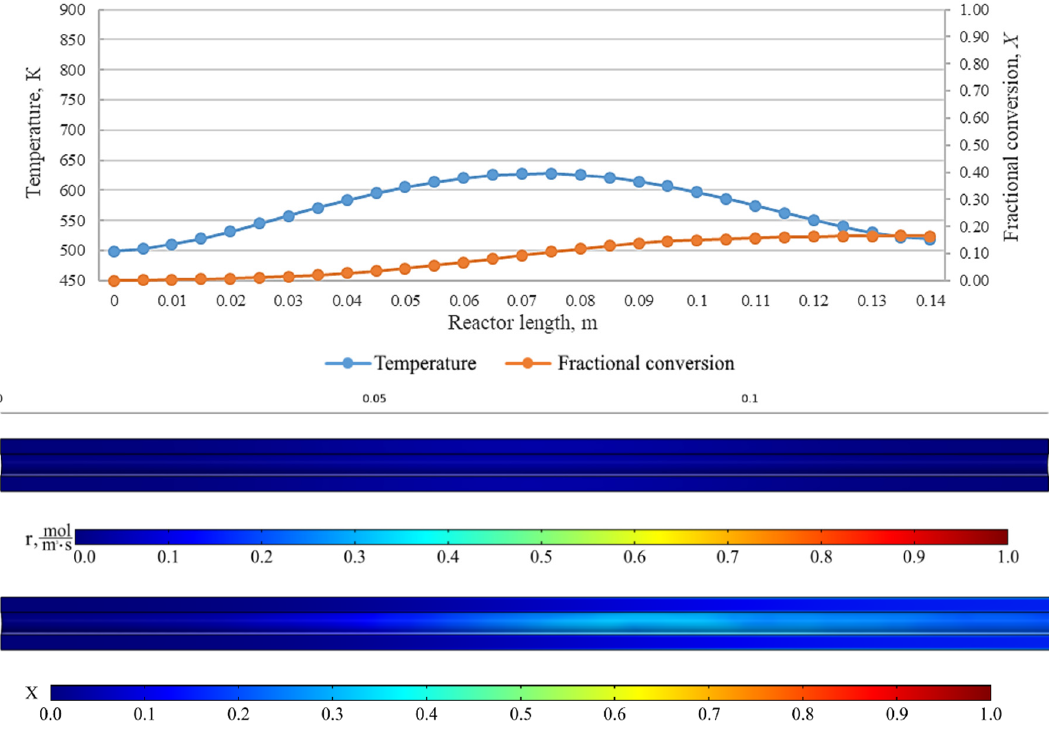
Figure 15. From top to bottom: temperature and fractional conversion curves, profiles of the reaction rate and fractional conversion along the reactor length for the experiment BuOm_350_72 (Tmax = 350 °С , 𝑉(cid:4662) = 0.1 L/min).